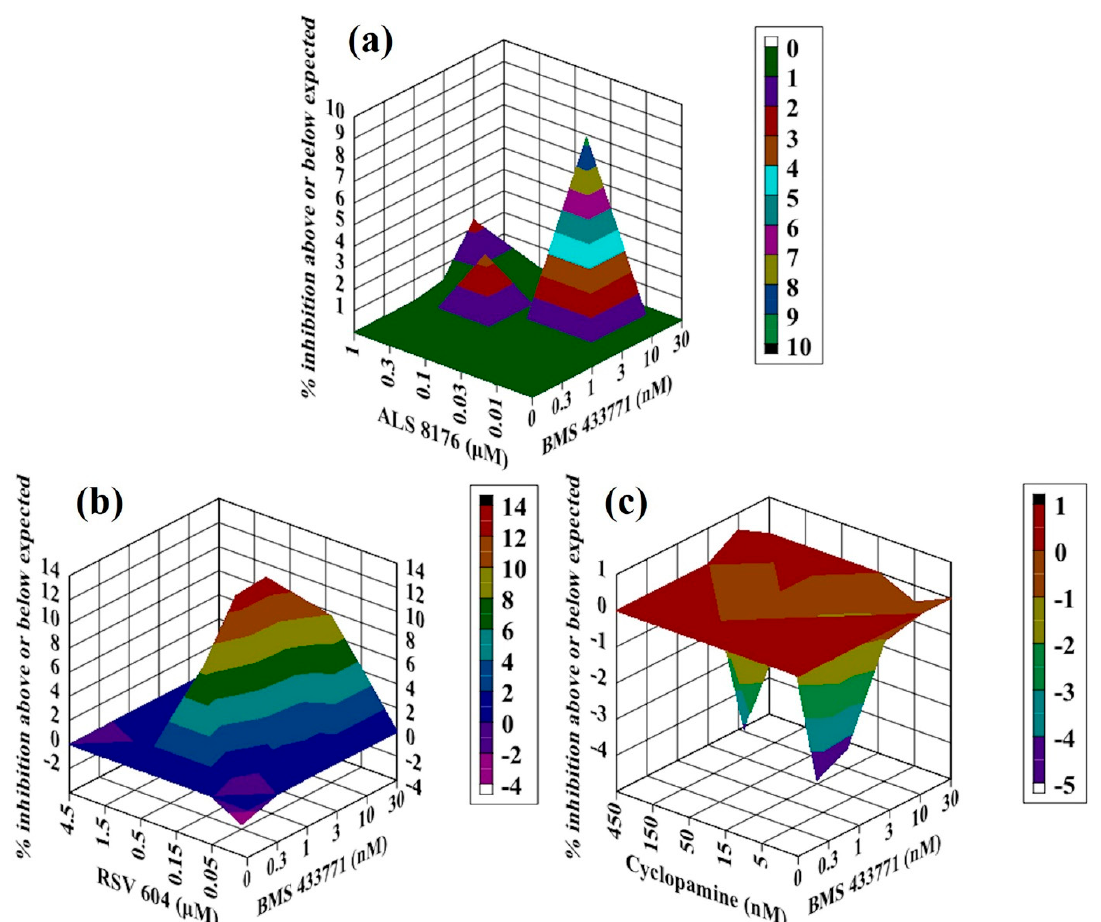
Figure 5. Analysis of compound interactions between RSV fusion inhibitor BMS433771 and RdRp inhibitors. HEp-2 cells infected with RSV–Luc were subjected to serial dilutions of BMS433771 (( a – c ); 0.3–30 nM), ALS8176 (( a ); 0.01–1 µM), RSV604 (( b ); 0.05–4.5 µM), or CPM (( c ); 5–450 nM) in a checkerboard method, and results were obtained via a luciferase activity reduction assay ( a – c ). Data shown were obtained using Macsynergy II program at 95% confidence interval and plotted with Delta Graph, and values on the Z-axis represent the mode of interaction between two selected compounds (>0, synergistic effect; <0, antagonistic effect; 0, additive effect). All data points represent averages of three measurements from three experiments.